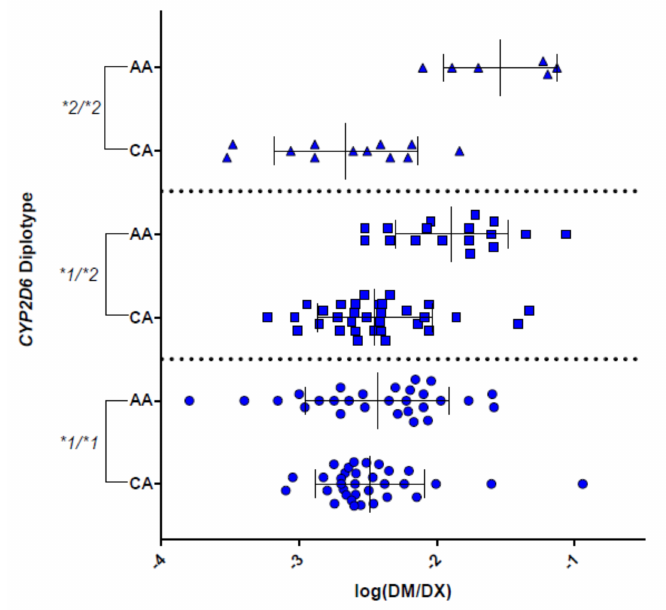
Figure 1. The urinary dextromethorphan/dextrorphan (DM/DX) ratio serves as a measure of CYP2D6 activity. The log-transformed ratios were stratified by CYP2D6 diplotype ( CYP2D6*1/*1 , *1/*2 , and *2/*2 ) and ethnicity (Caucasian (CA) vs. African-Americans (AA)). Statistically significant differences in activity were observed between these two ethnic groups for CYP2D6*1/*2 ( p < 0.0001) and *2/*2 ( p =